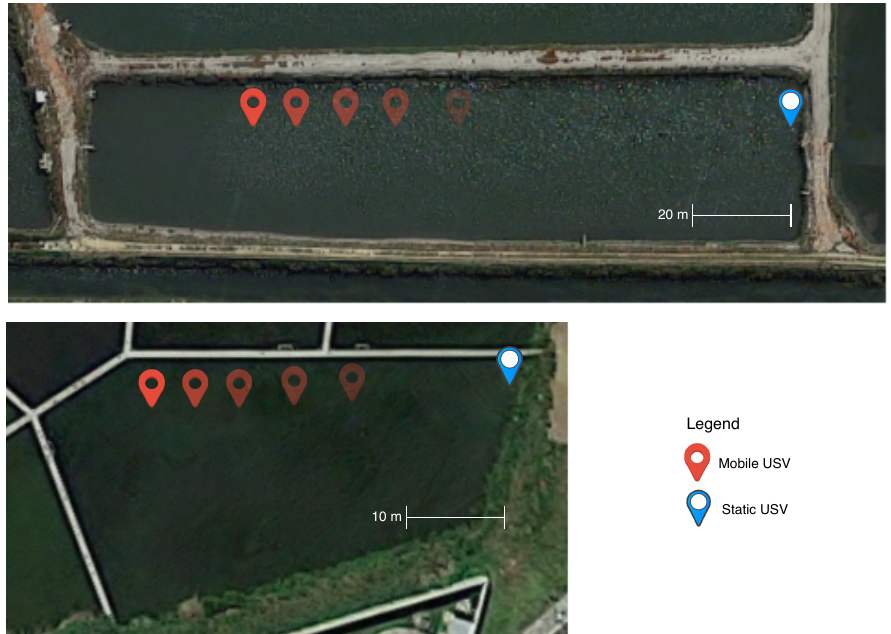
Figure 8. Two aquatic scenarios: ( top ) AlgaPlus scenario; and ( bottom ) the Water Biological Treatment Plant (WBTP) of the University of Aveiro scenario.